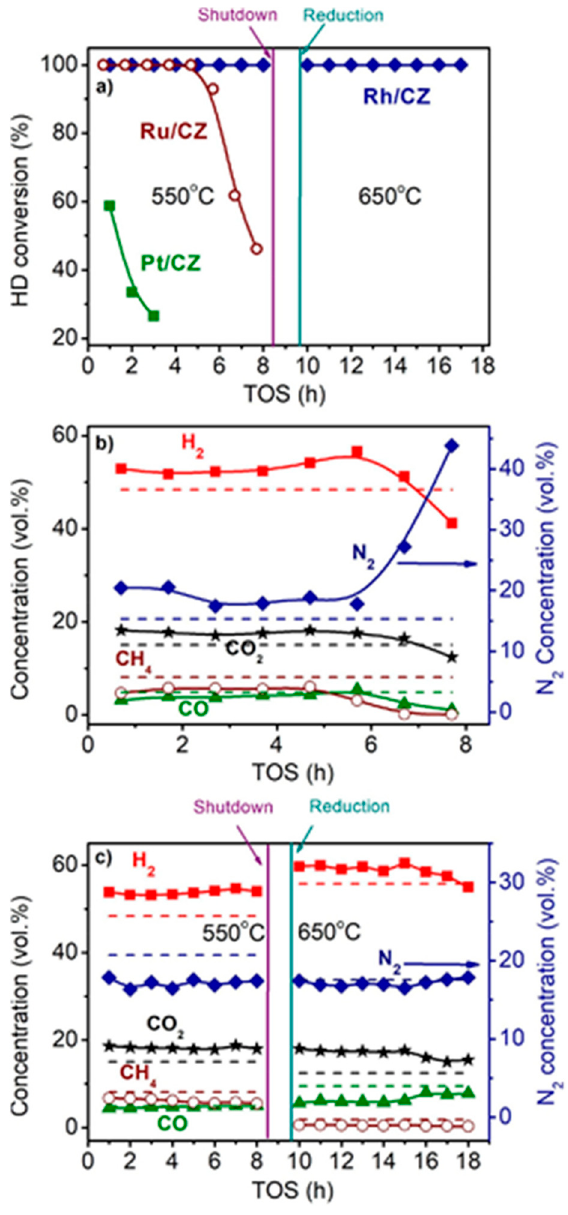
Figure 3. The HD conversion ( a ) and product distribution on dry basis ( b , c ) over 1.9 wt.% Pt/CZ ( a ), 1 wt.% Ru/CZ ( a , b ) and 1 wt.% Rh/CZ ( a , c ) in the HD SR as a function of time on stream at H2O/C = 3.0, T = 550–650 °C and GHSV = 23,000 h − 1 . Points—experiment, dashed line—equilibrium [49].